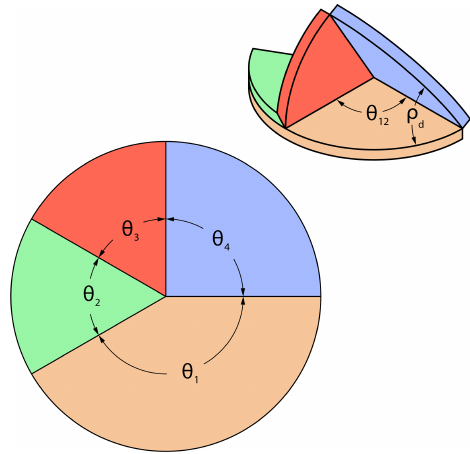
Figure 20. General diagram for a sector panel ThUDS with key parameters